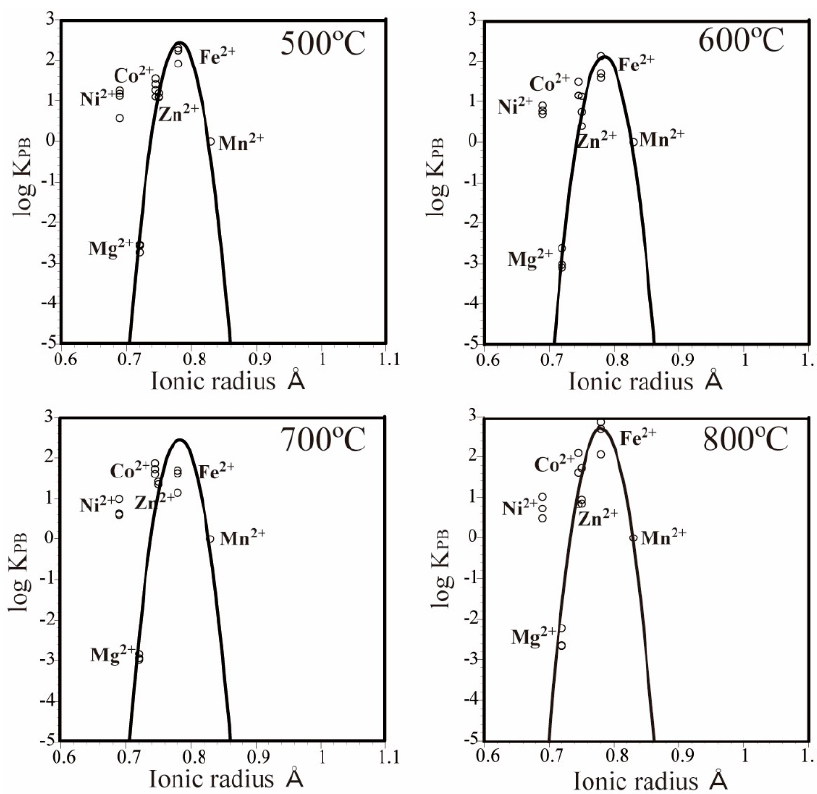
Figure 3. Partition coefficient-ionic radius (PC-IR) diagrams for the MnS–(Ni, Mg, Co, Zn, Fe)Cl 2 –H 2 O system. The PC-IR curves were drawn using a least squares method and assuming that Mg 2+ , Co 2+ , Fe 2+ , and Mn 2+ will show partitioning behavior according to their ionic radii.